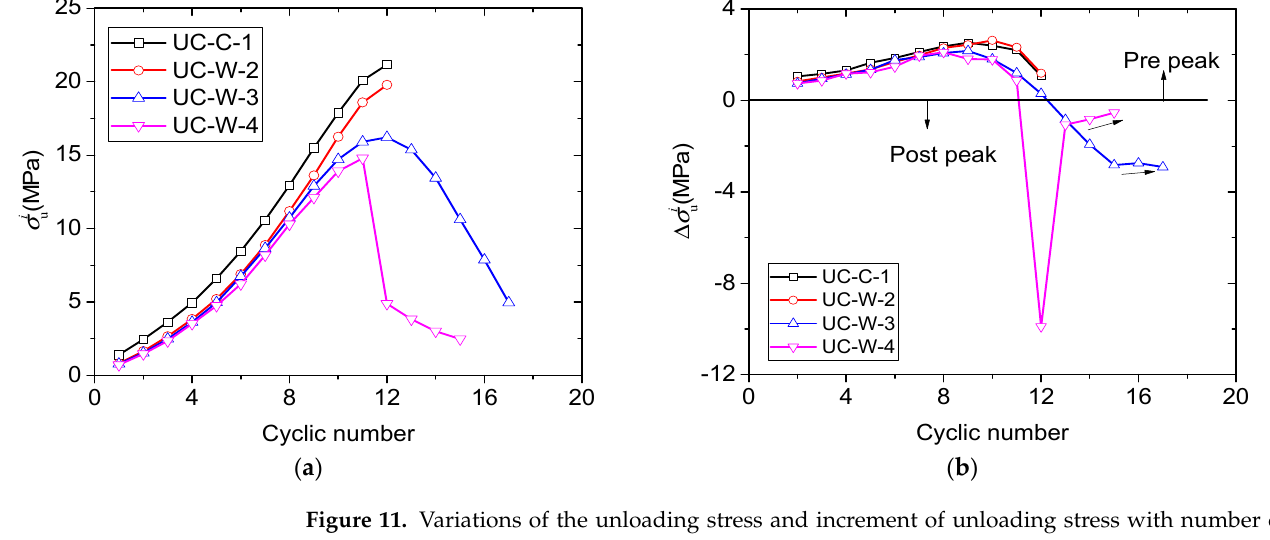
Figure 11. Variations of the unloading stress and increment of unloading stress with number of cycles: ( a ) relationship between unloading stress and number of cycles and ( b ) relationship between the increment of unloading stress and number of cycles.